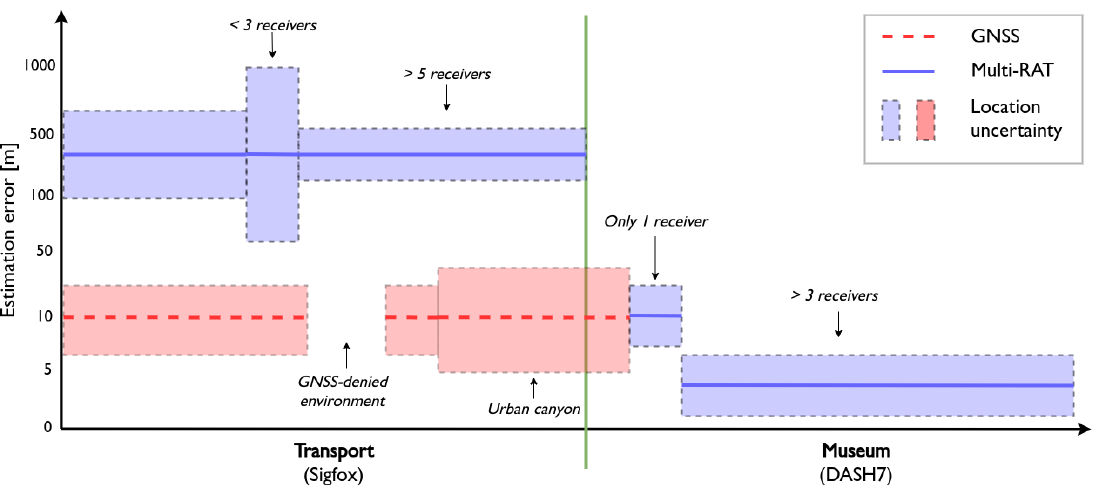
Figure 4. The expected accuracy and reliability for both GNSS as GNSS-less localization with our multi-RAT artwork tracking device. The expected estimation errors are based on results from related work in Section 2, and are displayed on a logarithmic